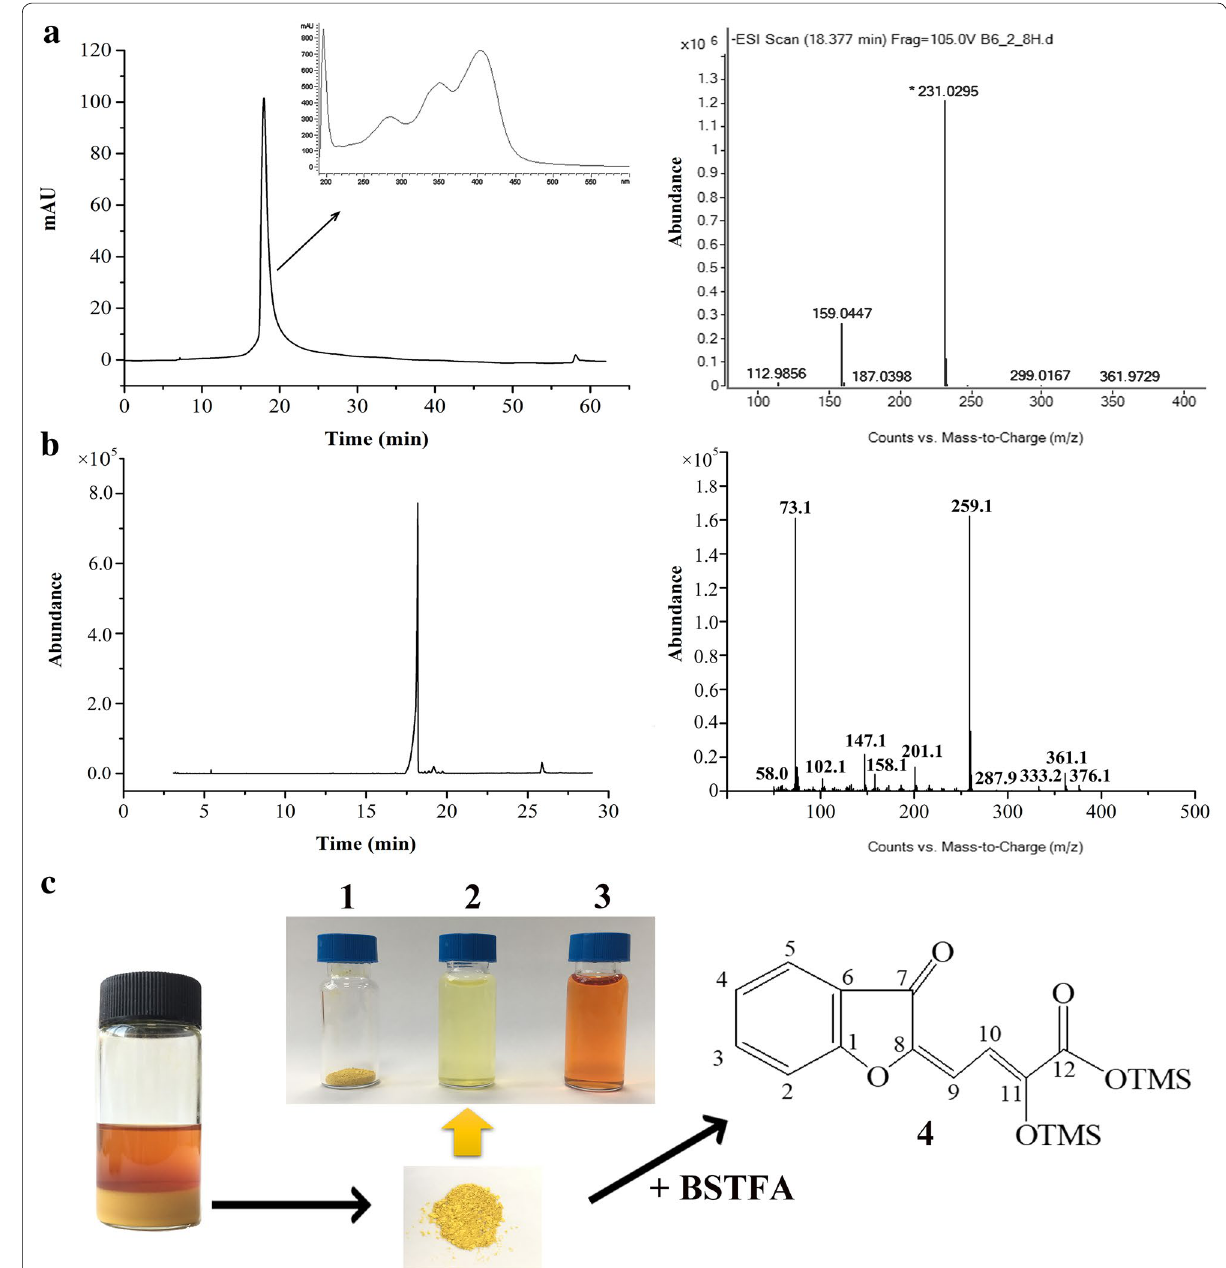
Fig. 4 Preparation and identification of HOBB by mass spectra and NMR analysis. a HPLC detection revealed a peak at RT 18.377 min ( λ with UV–Vis spectra in the acid mobile phase, and mass spectra verification revealed a molecular ion peak (M − ) at m/z 231.0299 (C 12 H 8 O 5 ) consistent with HOBB. b GC–MS detection of silylated HOBB (derived with BSTFA) with one major peak at RT 18.1 min, showing main ion peaks at m/z 376, 259, 147 and 73. c When preparing HOBB, the sediment was purified by washing with a small amount of ethyl acetate. Purified HOBB was a yellow powder ( 1 ). This powder turned yellow–green in color when dissolved in ethyl acetate ( 2 ) and dark-orange in color when dissolved in DMF ( 3 ). The structure of silylated HOBB was determined by NMR analysis (derived with BSTFA) ( 4